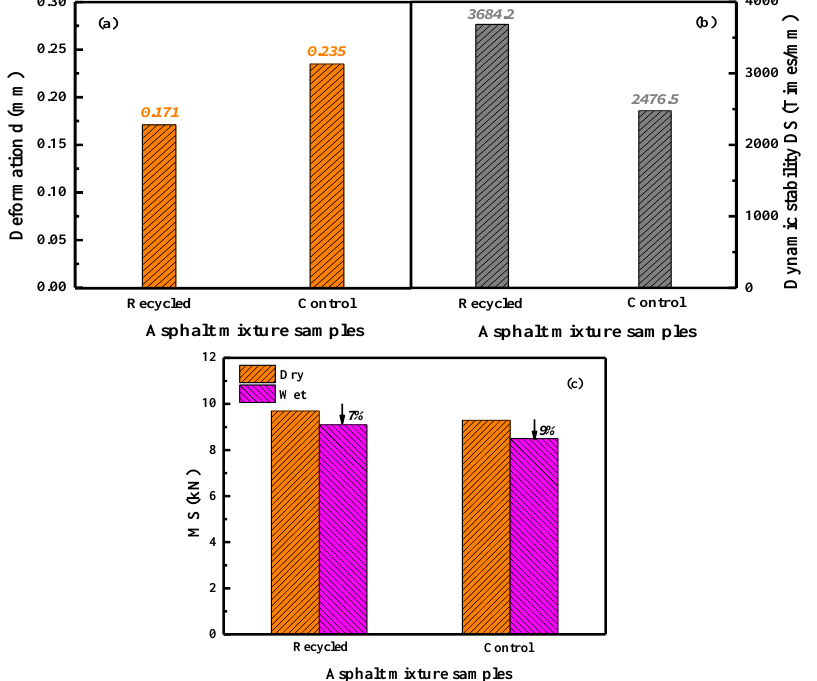
Figure 18. The rutting deformation ( a ), dynamic stability ( b ), and moisture sensitivity ( c ) of recycled and control asphalt mixtures. and control asphalt